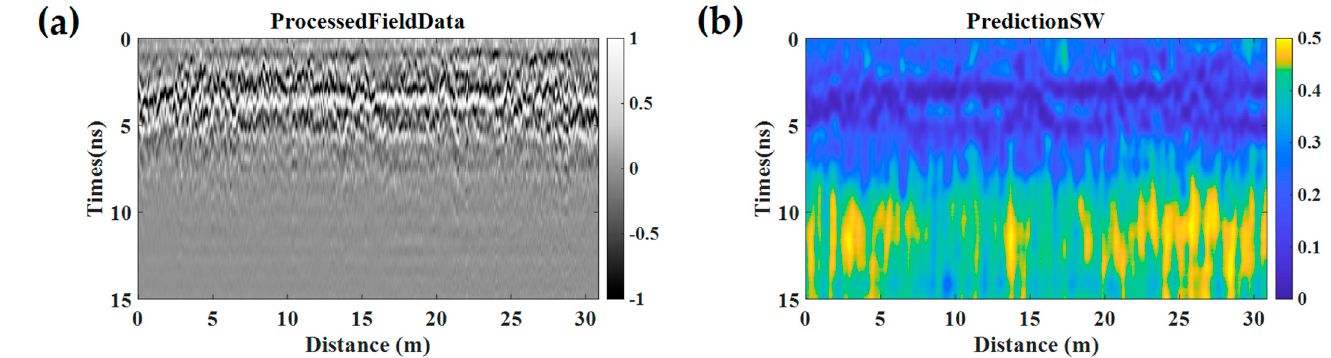
Figure 9. ( a ) Processed GPR data under line 2; ( b ) VSWC predicted value under line 2.